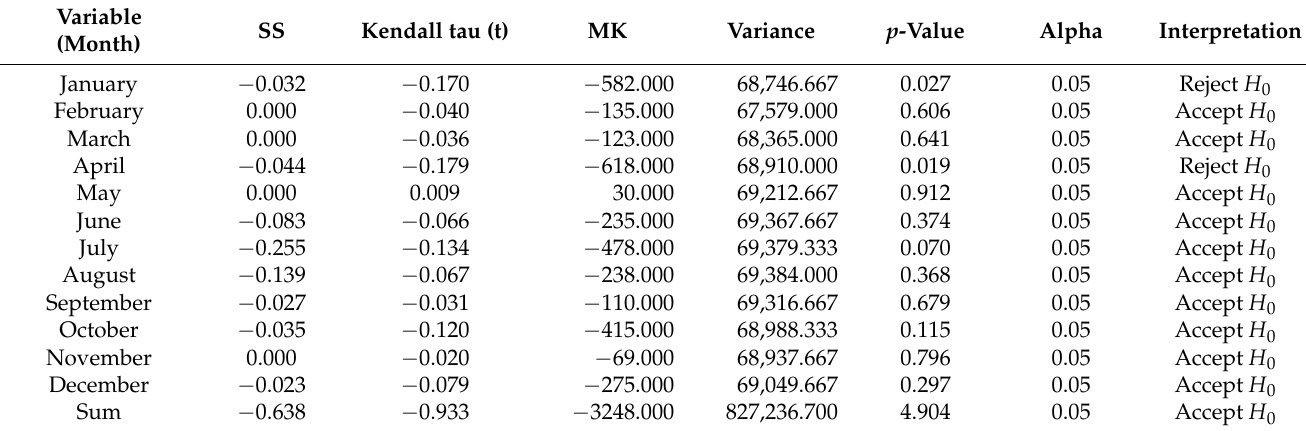
Table 6. SS and MK test results for the Ulan-Ude station.